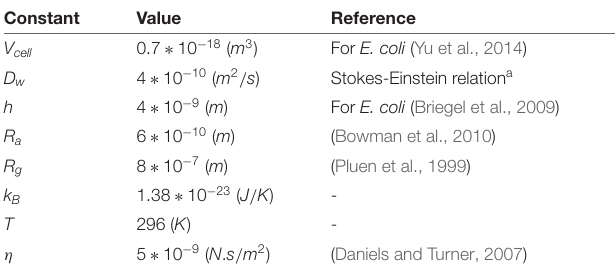
TABLE 2 | Constant